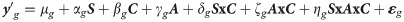
Gene-set enrichment analysis for gene expression across vital status.The x-axis corresponds with the sorted effects of vital status, estimated assuming the following probabilistic model y′g=μg+αgS+βgC+γgA+δgSxC+ζgAxC+ηgSxAxC+εg for the expression of 19,535 genes. The light green and blue rectangles represent the up and down regulation regions defined by the third and first quartile, respectively. The vertical bars represent a target set of genes involved in alcohol metabolism. The black curve shows the estimated running enrichment score, and the dashed line shows the threshold for random disposition of the target set. The p-value was obtained by modified Kolmogorov-Smirnov (KS) test over the maximum value of the enrichment score. Genes in the target set: XRCC1, CYP1B1, XPC, GSTP1, OGG1, MTHFR, ADH1C, AOX1, XDH, ALDH2, ERCC2, COMT, CBS, CYP2E1, SOD2, and ITGA5.